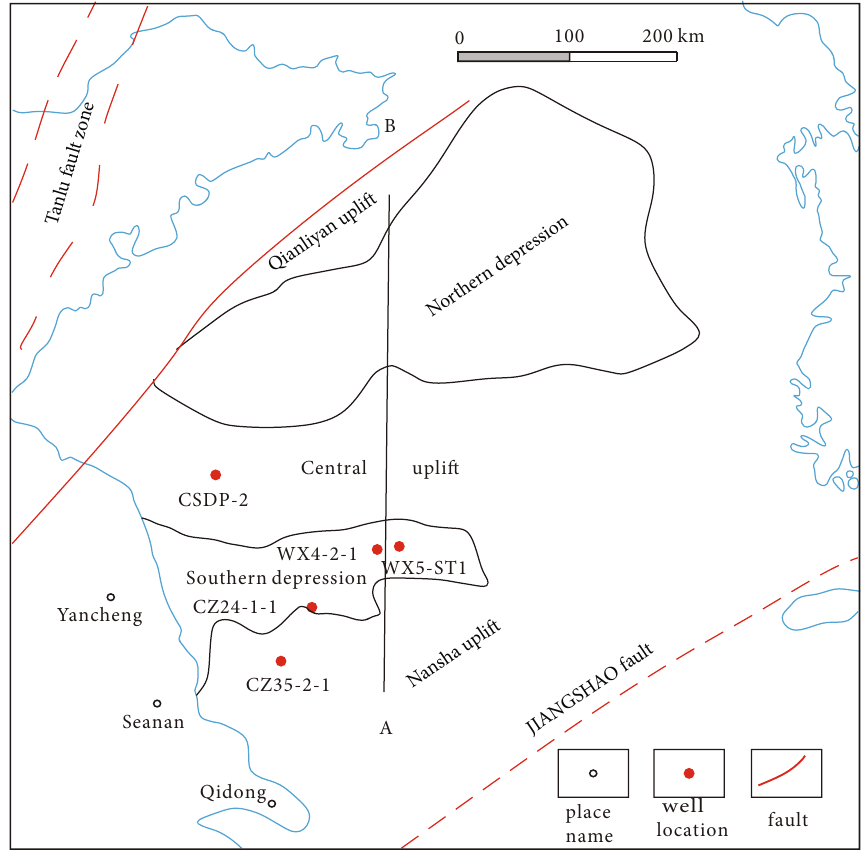
Figure 2: Plane distribution of Triassic wells drilled in the South Yellow Sea Basin